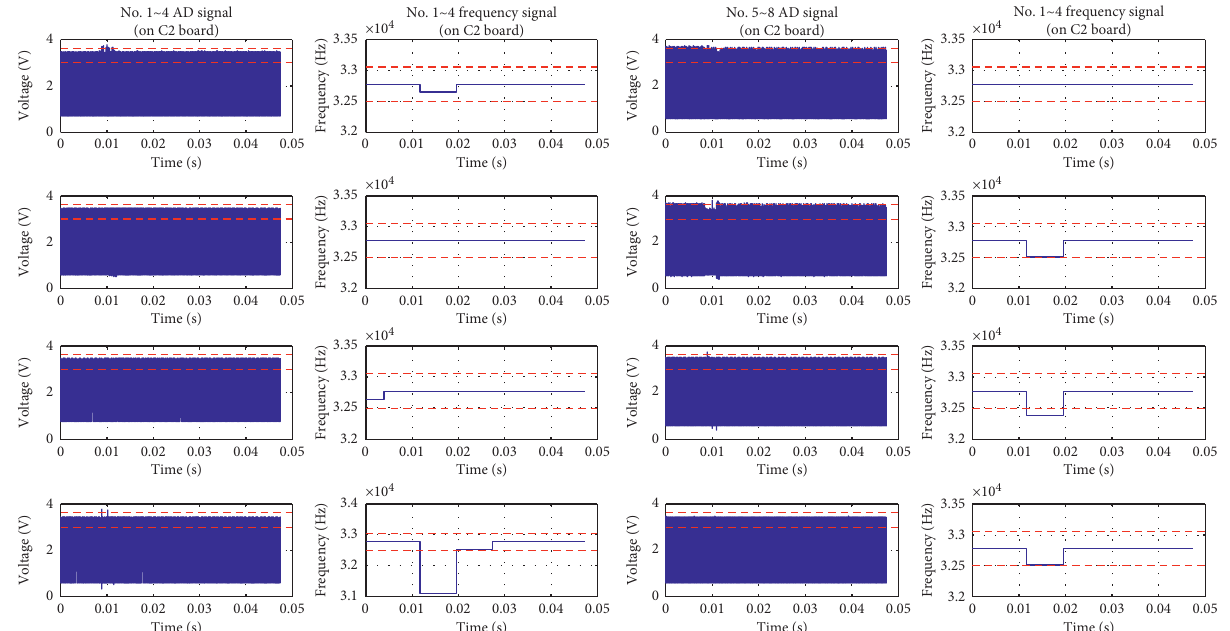
Figure 13: Electrical performance of the crystal oscillators on test board